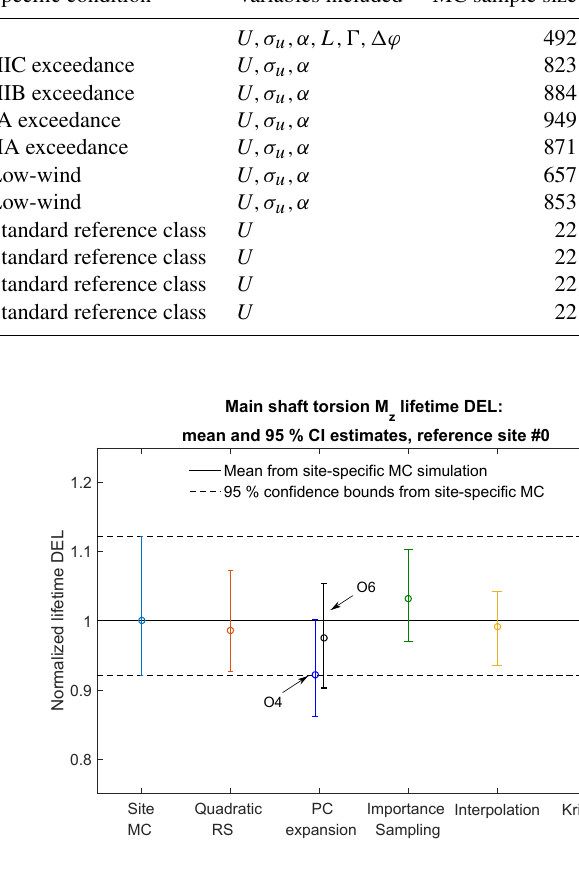
Figure 7. Comparison of predictions of the lifetime damage- equivalent loads (DELs) for six different estimation approaches. All values are normalized with respect to the mean estimate from a site- specific Monte Carlo (MC) simulation, and the error bars represent the bounds of the 95% confidence intervals (CIs). Results from two PCEs are shown: the blue bar corresponds to the output of a fourth- order PCE, while the black bar corresponds to a sixth-order